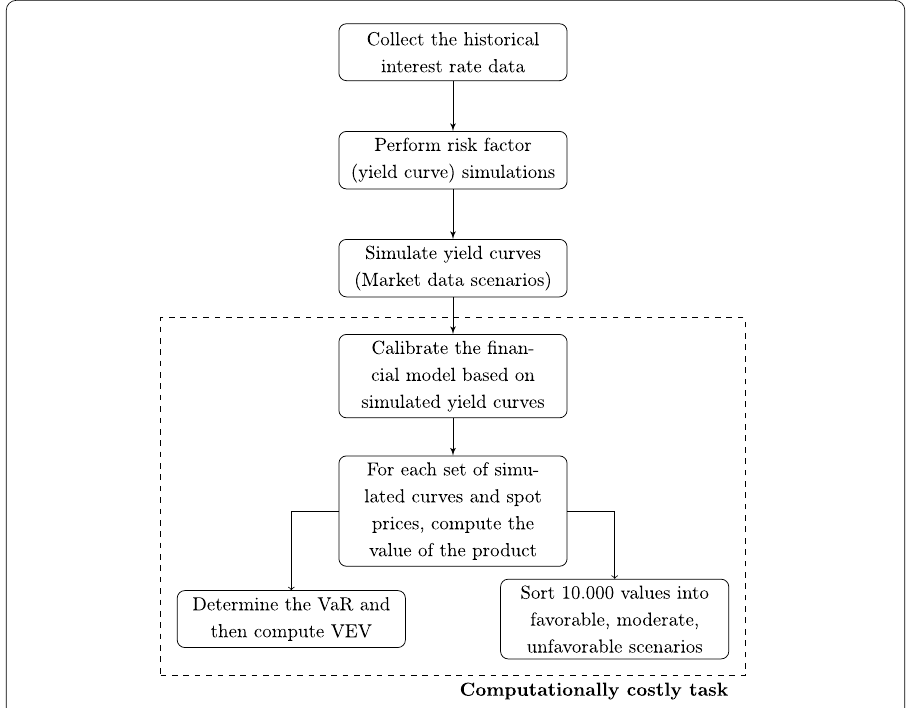
Figure 1 The calculation steps for category three instruments